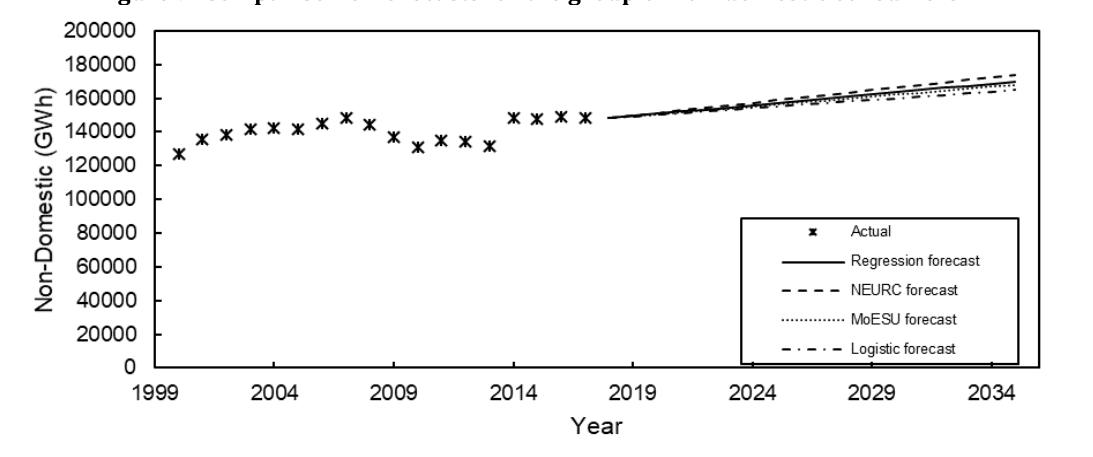
Figure 9: Comparison of forecasts for the group of non-domestic consumers.